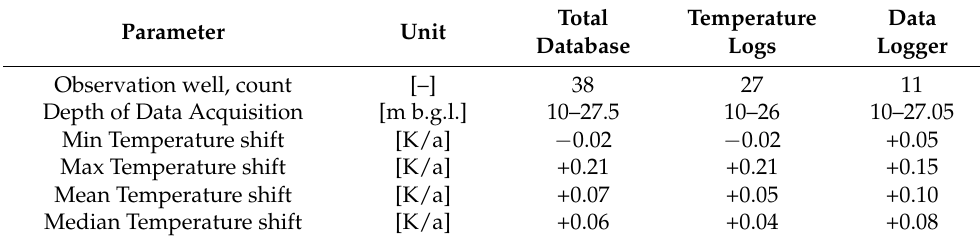
Figure 5. Recorded temperature curves of four data loggers. All evaluated data loggers show a constant, positive temperature trend within the last years. Although the data loggers are located within the neutral zone, seasonal oscillations are indistinctly ( A ) to clearly ( B – D ) visible, which can be attributed to temperature-related convection currents within the groundwater monitoring well. Table 3. Determined temperature shifts of the